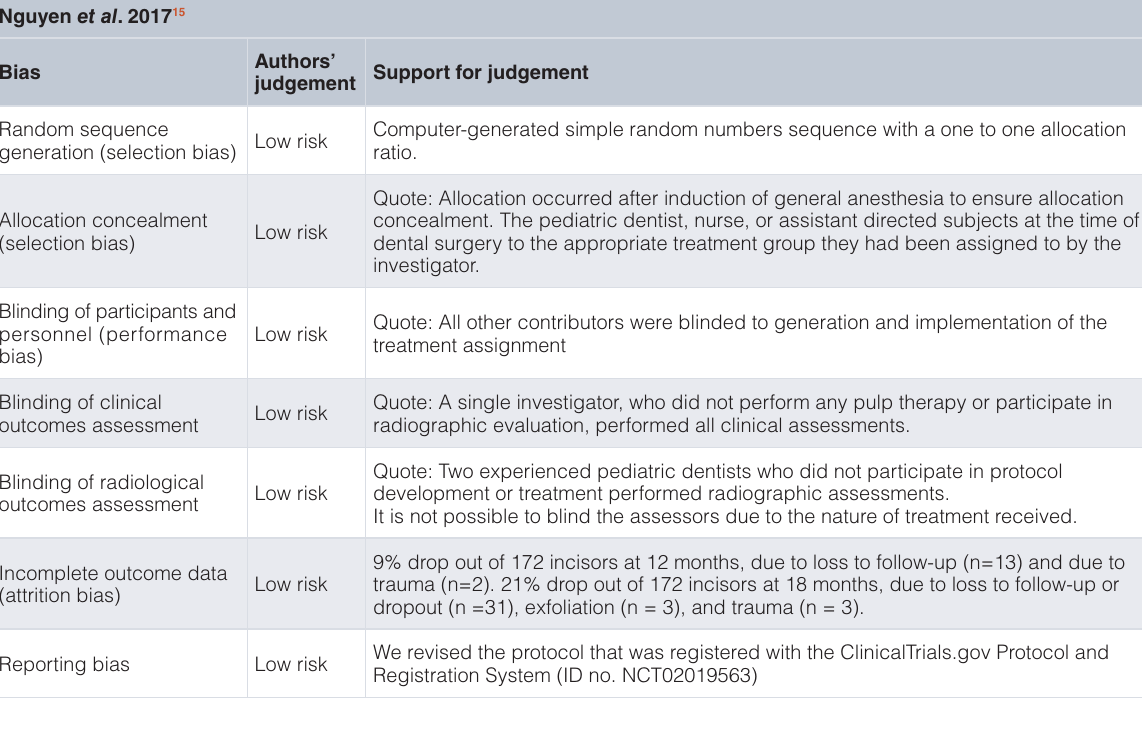
Authors’ Support for judgement judgement Low